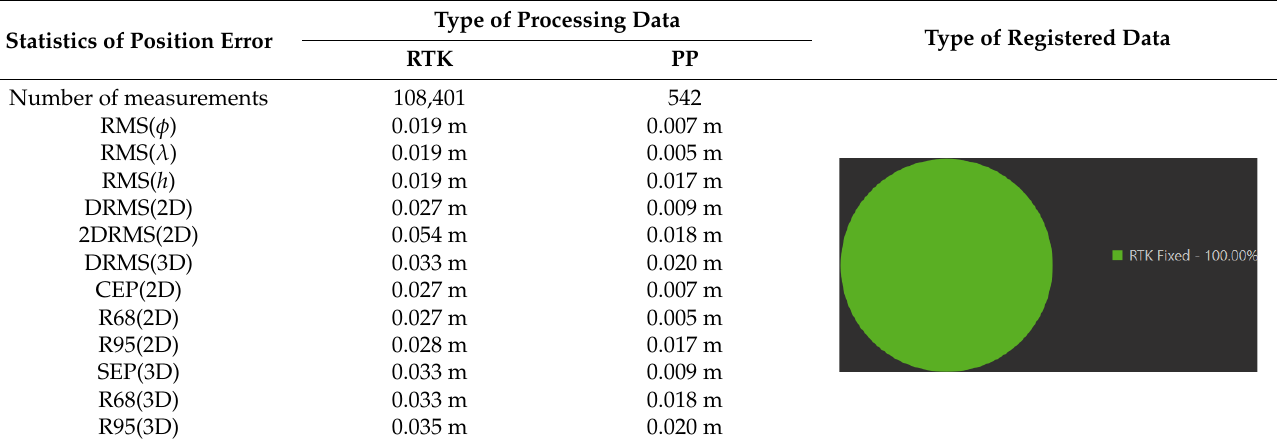
Table 2. Predictable accuracy of the Ekinox2-U system during the GNSS/INS measurements in section no. 1.